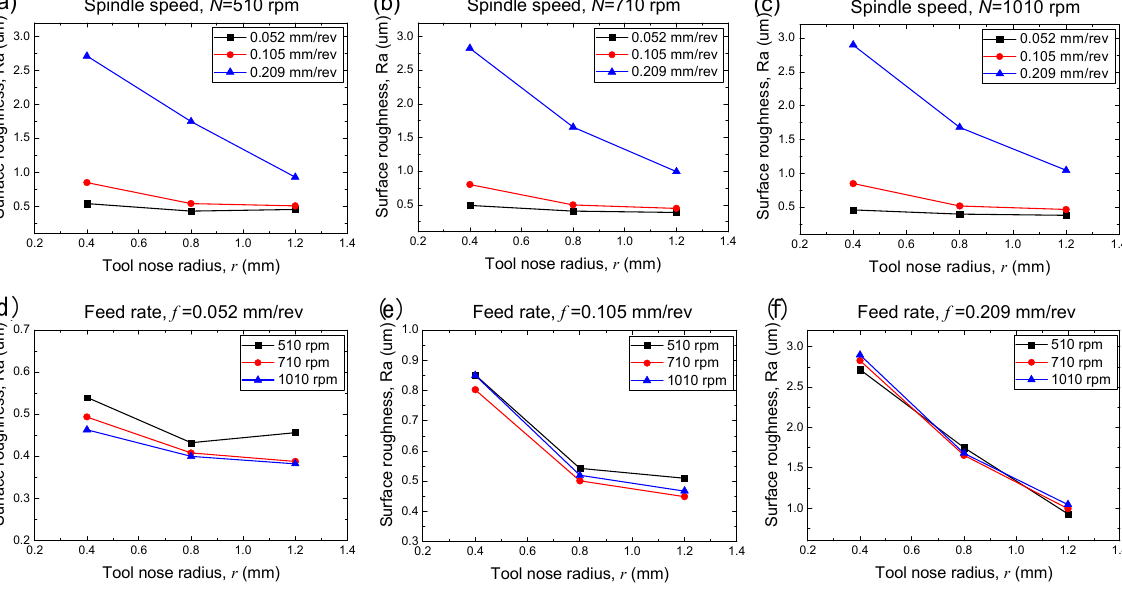
Figure 3. Effect of tool nose radius ( r 1 , r 2 , r 3 ) on surface roughness (R a ) for different ( a – c ) spindle speeds ( N ) and ( d – f ) feed rates ( f ).